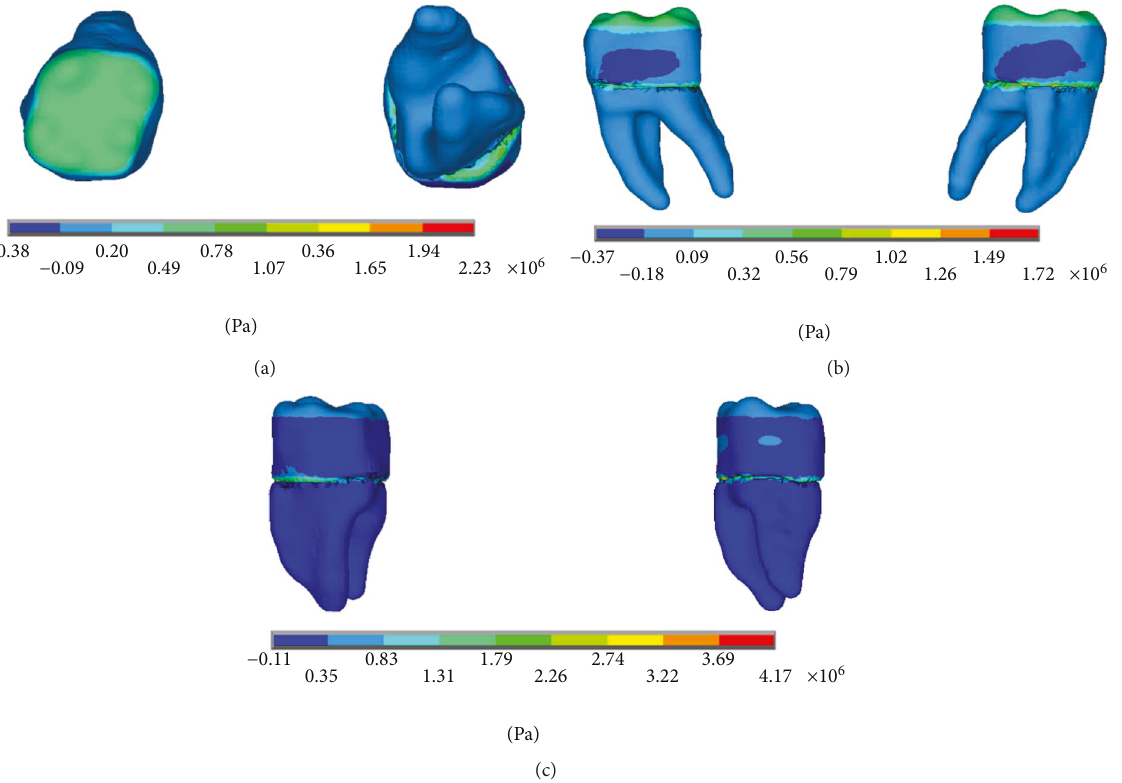
Figure 19: Nominal stress of the noncontact simulation. (a) x -axis. (b) y -axis. (c) z